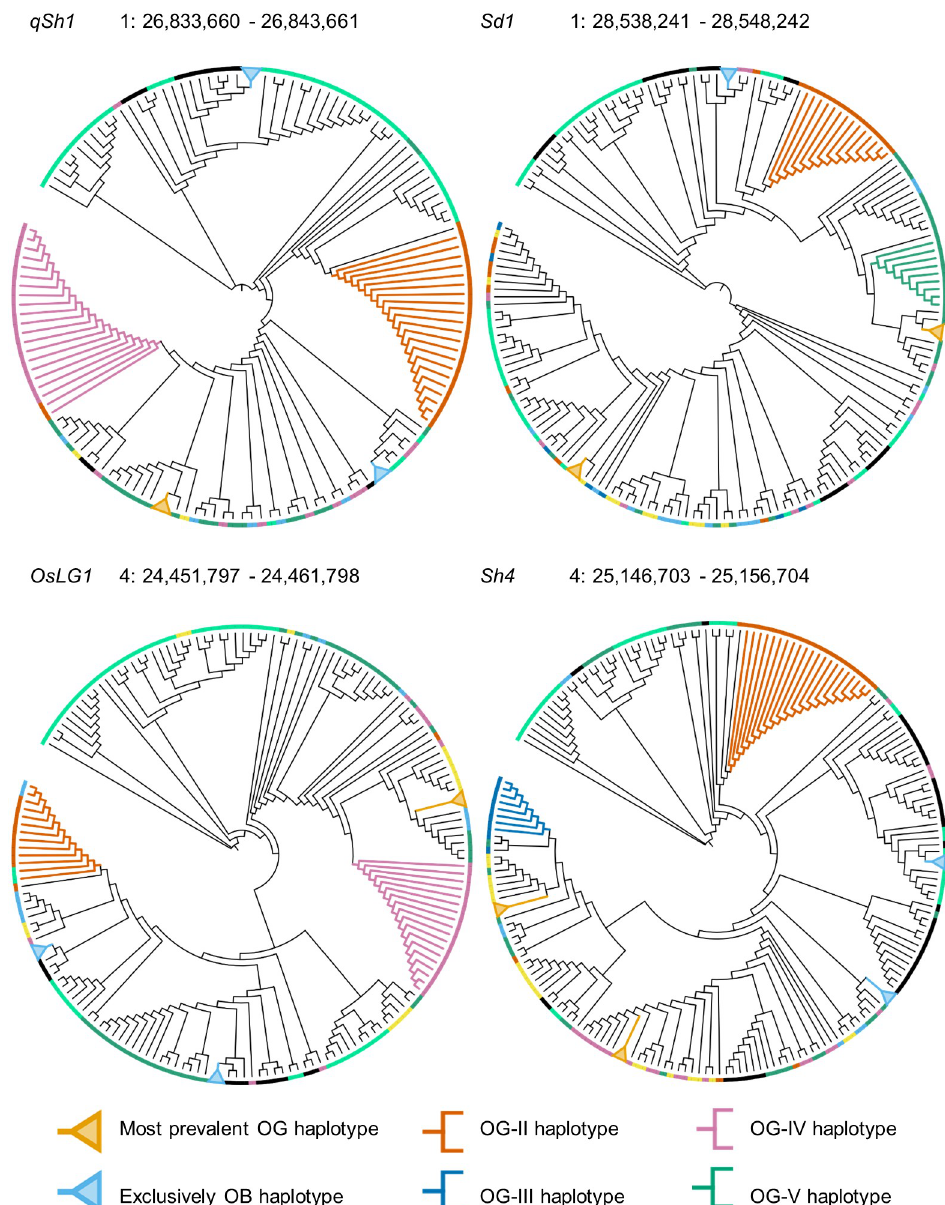
Fig 6. Separation of OG-II haplotype in multiple domestication genes. The five (or in case of equal haplotype counts, six) largest haplotypes are labelled. The most common haplotypes, containing accessions from multiple sub- populations O . glaberrima , are collapsed into orange nodes. Haplotypes that consist exclusively of O . barthii are collapsed into blue nodes. Remaining haplotypes, consisting of a mix O . barthii and O . glaberrima accessions from a single subpopulation, are expanded with branch colours reflecting their population of origin of the O . glaberrima accessions.